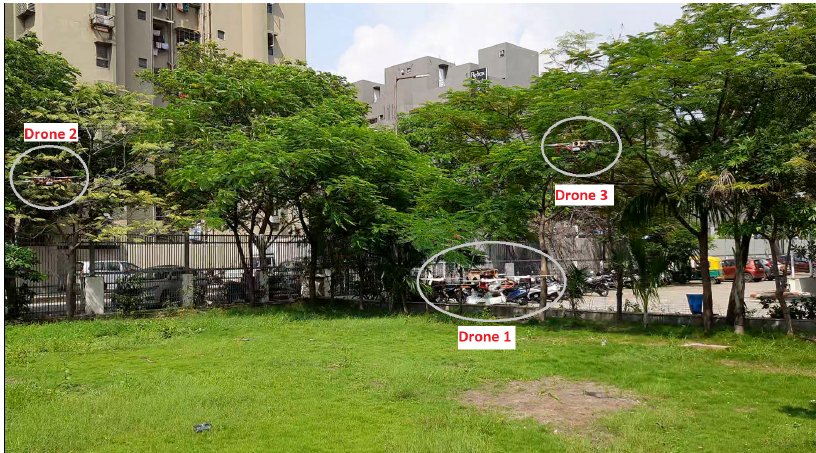
Figure 13. Drone initial formation during the field